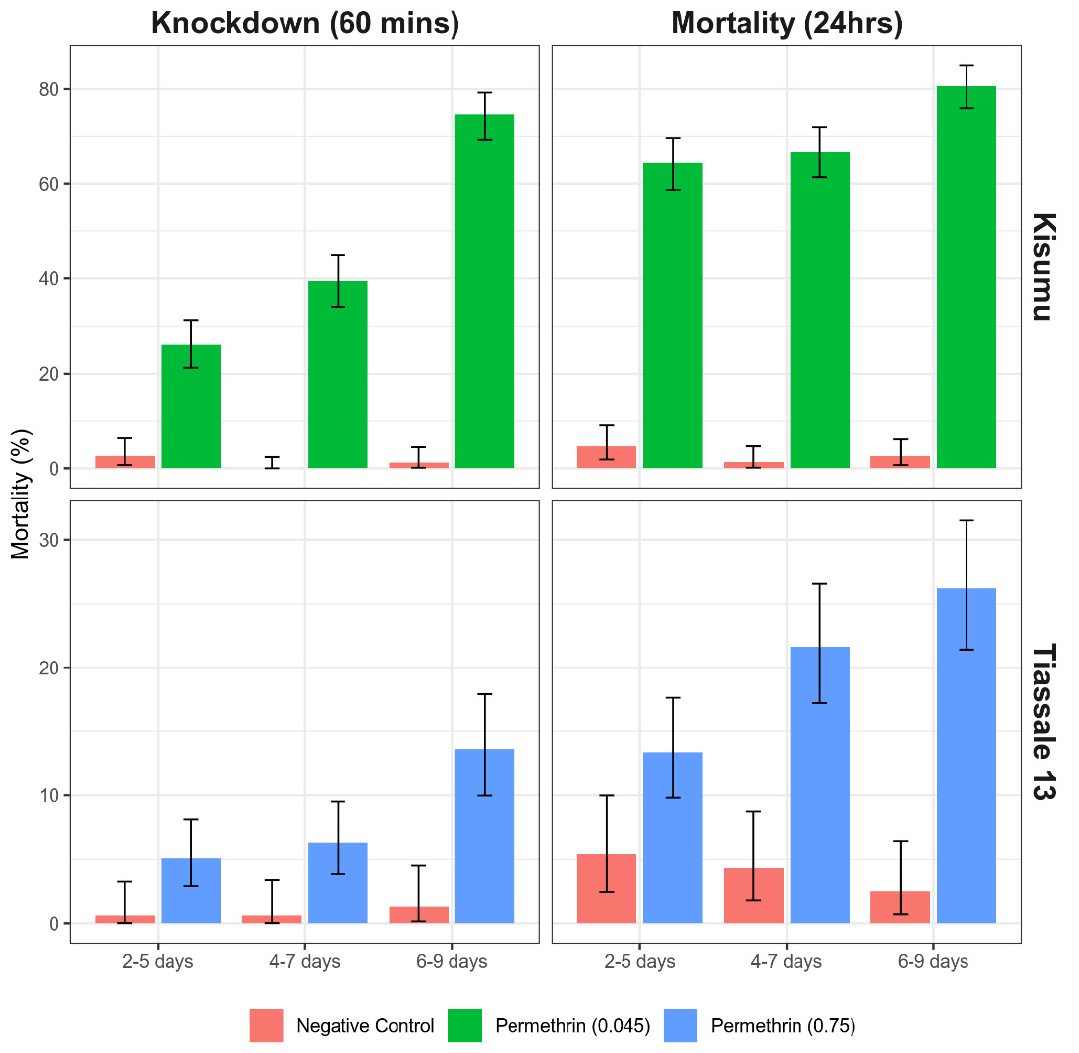
Figure 7. Bioassay data looking at how age of mosquitoes used in testing may impact the result of standardized bioassay testing for a susceptible Anopheles gambiae Kisumu strain and a resistant Tiassalé 13 strain. Error bars equate to the 95% confidence intervals of the proportion.